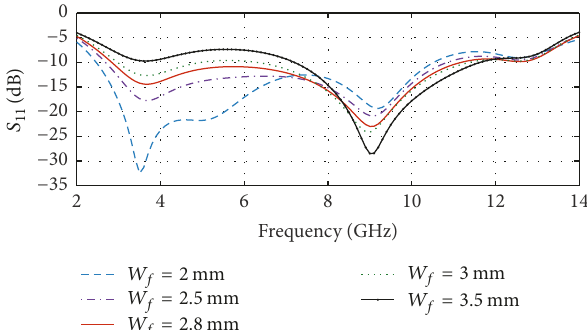
Figure 6: Effect of feed width on impedance bandwidth.